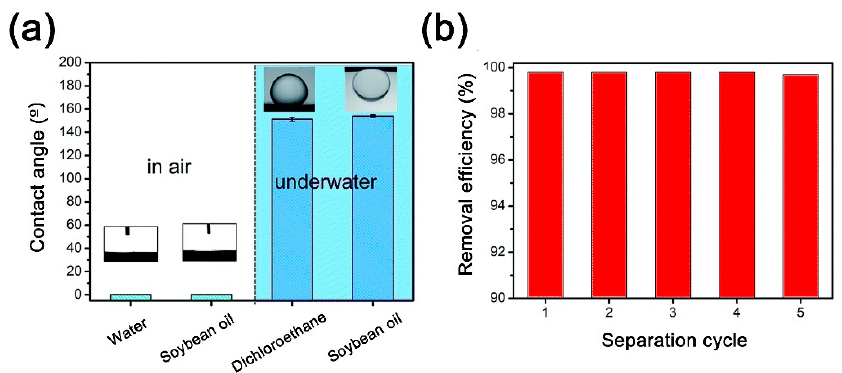
Figure 14. ( a ) Contact angles of water and oil in air and under water. ( b ) Separation efficiency versus the recycling number. Reproduced and adapted from Ref. [59]; Copyright (2019), RSC Journal of Materials Chemistry A.